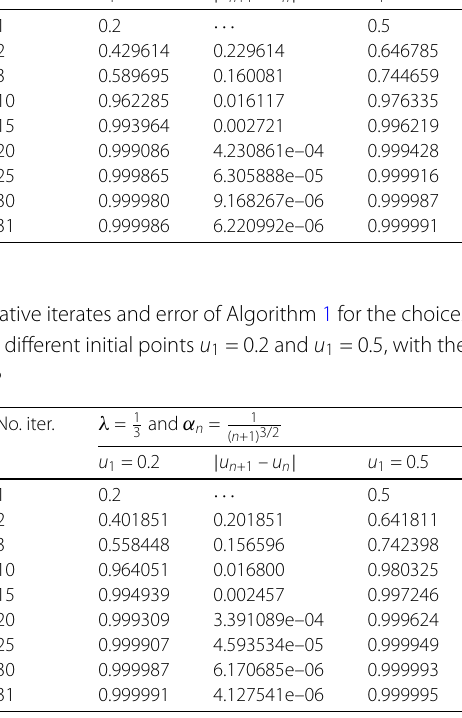
Table 1 Computative iterates and error of Algorithm 1 for the choices of different parameters λ = 1 and α n = 1 , different initial points u 1 = 0.2, u 1 = 0.5 and the tolerance of error | u n +1 – u n | < 10 –6 n +1